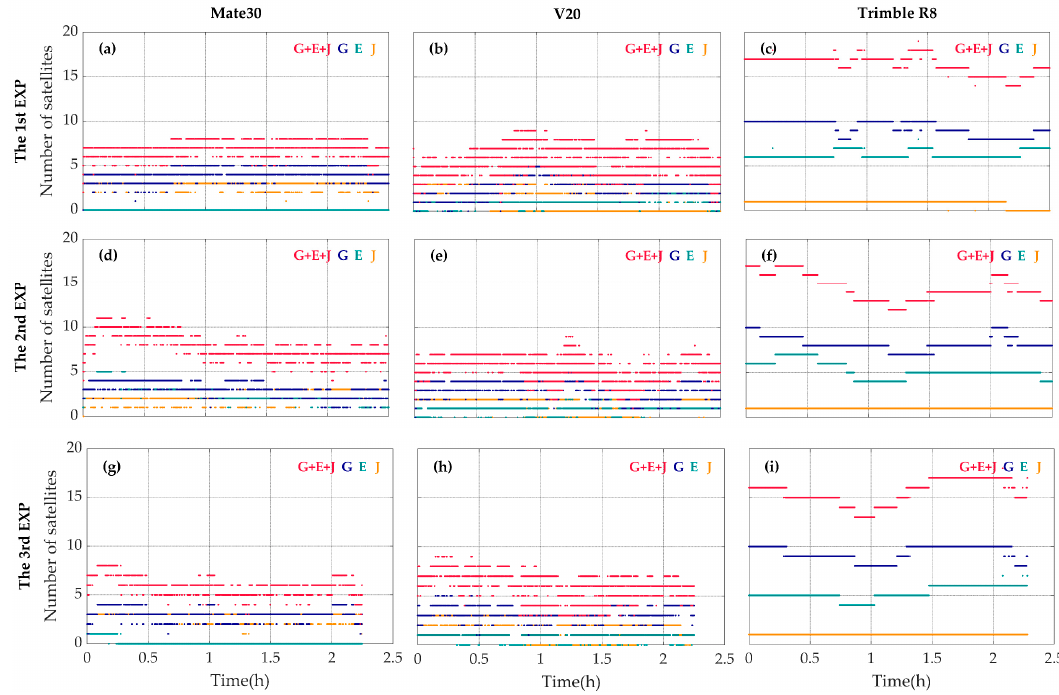
Figure 5. The numbers of GPS (blue), Galileo (cyan), QZSS (orange) and the total satellites of these three systems (red) with dual-frequency measurements available for the Mate30 smartphone ( a , d , g ) and the V20 smartphone ( b , e , h ) and the geodetic receiver Trimble R8 ( c , f , i ) during the first ( a – c ), the second ( d – f ) and the third ( g – i ) observing periods.